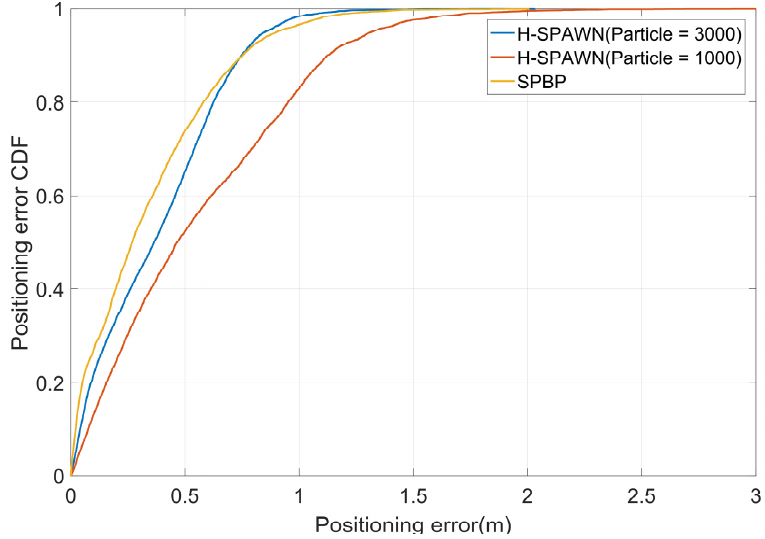
Figure 13. Positioning error CDF comparisons: H-SPAWN (Particle number = 3000), H-SPAWN (Particle number = 1000), SPBP.